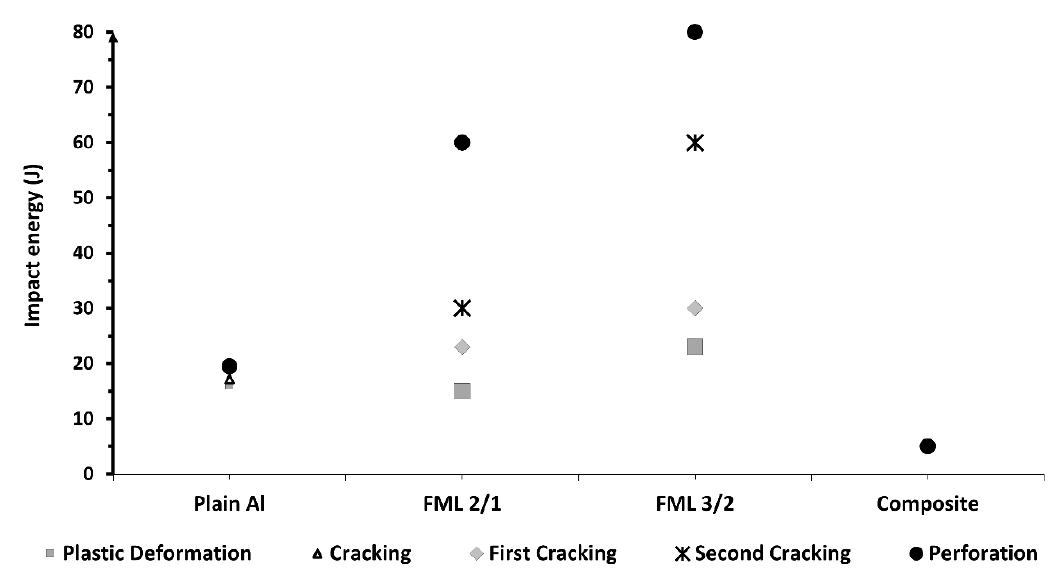
Figure 13. Impact energies for FMLs and constituent materials.